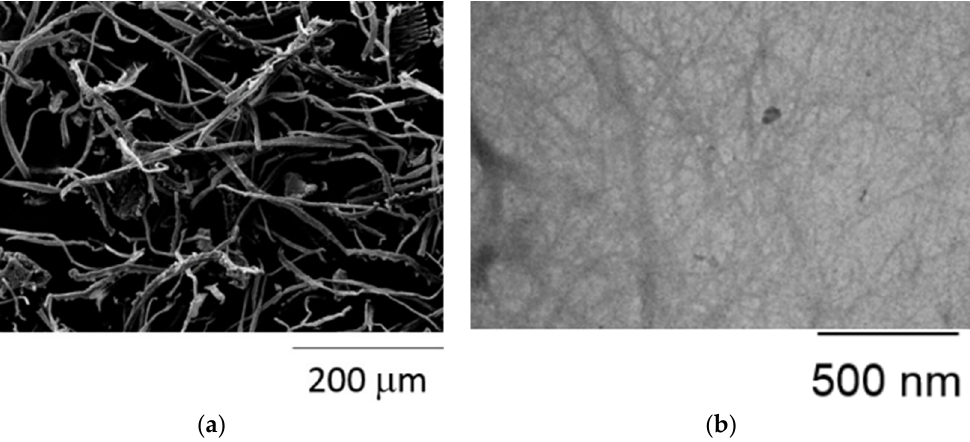
Figure 4. ( a ) Micrograph obtained using SEM of rice husk treated with NaOH followed by peracetic acid, and ( b ) micrographs obtained using TEM of the cellulose nanofibers from rice husk (extraction at 2 h). Reprinted with permission from Ref. [24]. Copyright 2016, Materials Research .